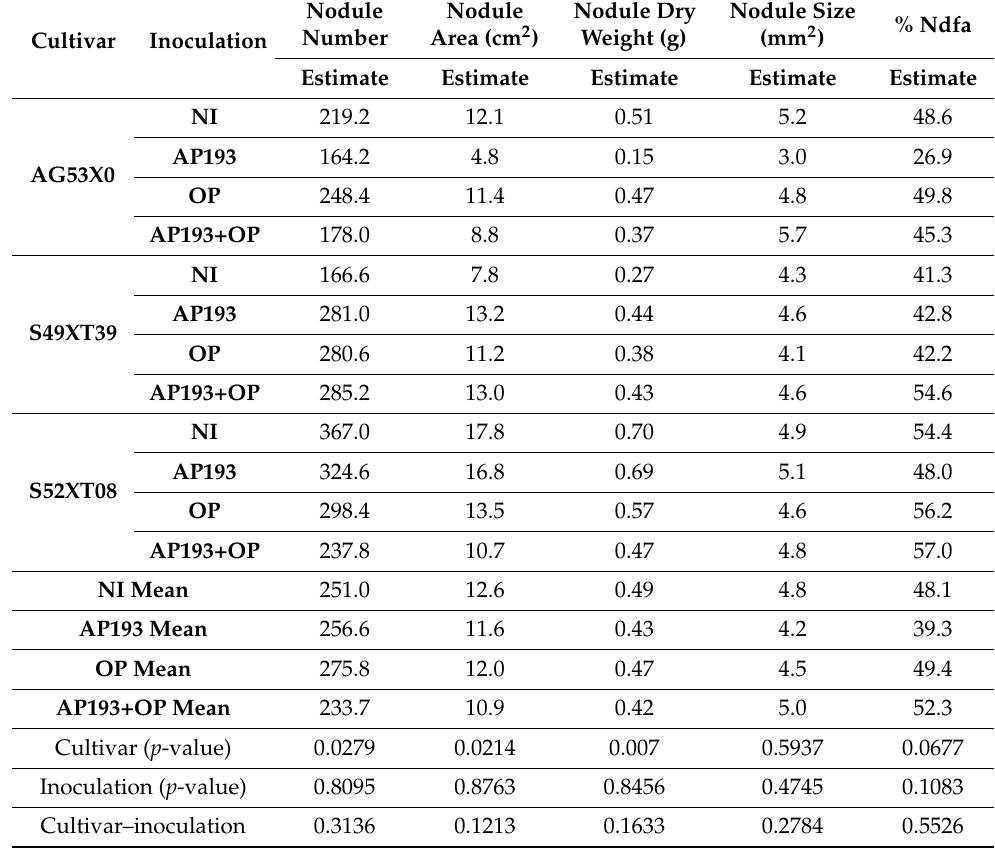
Cultivar ( p -value) Inoculation ( p